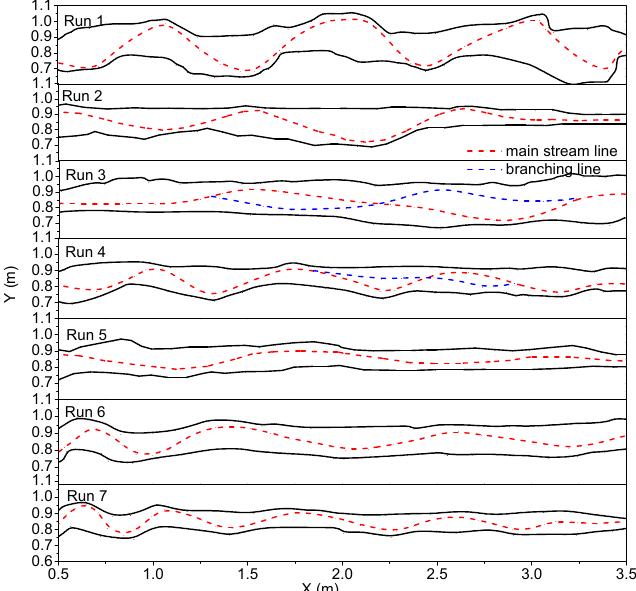
Figure 9. River bank-lines and dynamic axis for seven different experimental runs at the final relative stability moment.